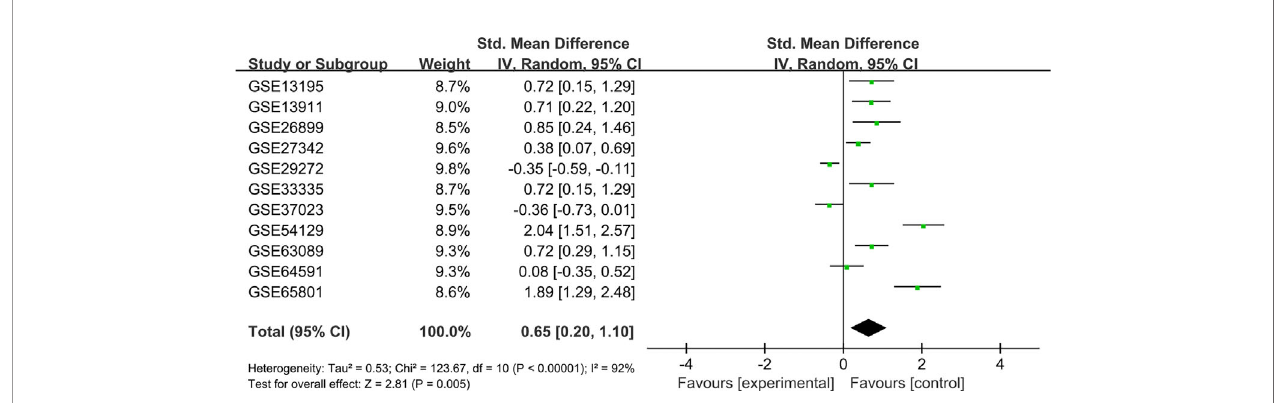
FIGURE 2 | Meta-analysis of GUCY1A2 expression data from GEO microarrays. The pooled SMD of GUCY1A2 was 0.65 (95%CI: 0.20-1.10) by the random effects model. GEO, Gene Expression Omnibus; SMD, standard mean difference; CI, con fi dence interval.